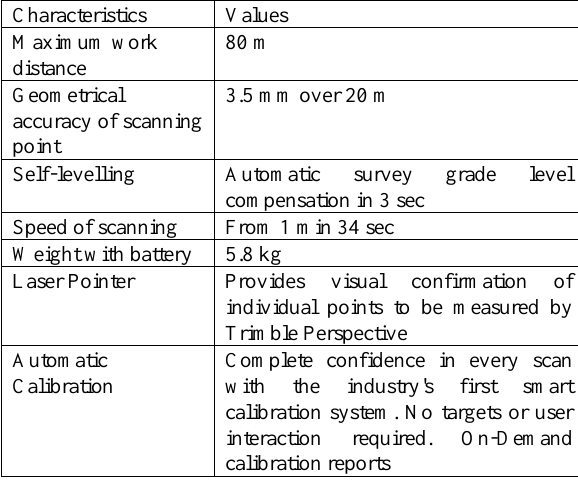
Table 1. Characteristics of Trimble X7 laser